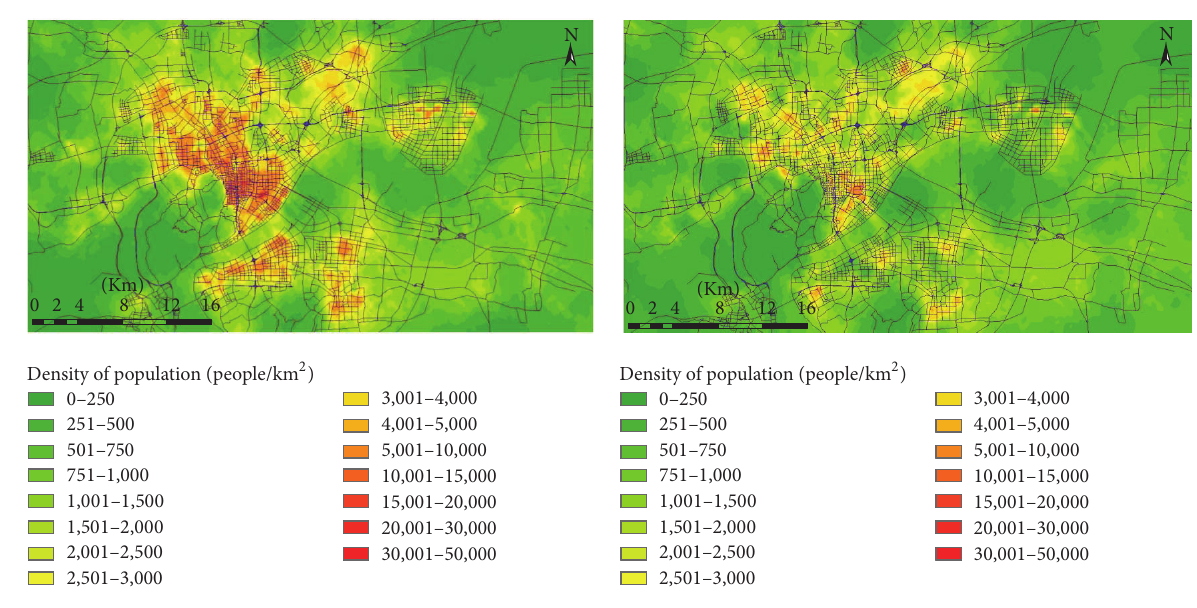
strategies in terms of deploying our bus-related resources and services. Most of the TCI 𝑖 in the AM peak hours are higher than those in the PM hours according to Figure 7(c) and the outliers show that TCI 𝑖 of some TAZs significantly vary with time periods and different travel demands. Transit